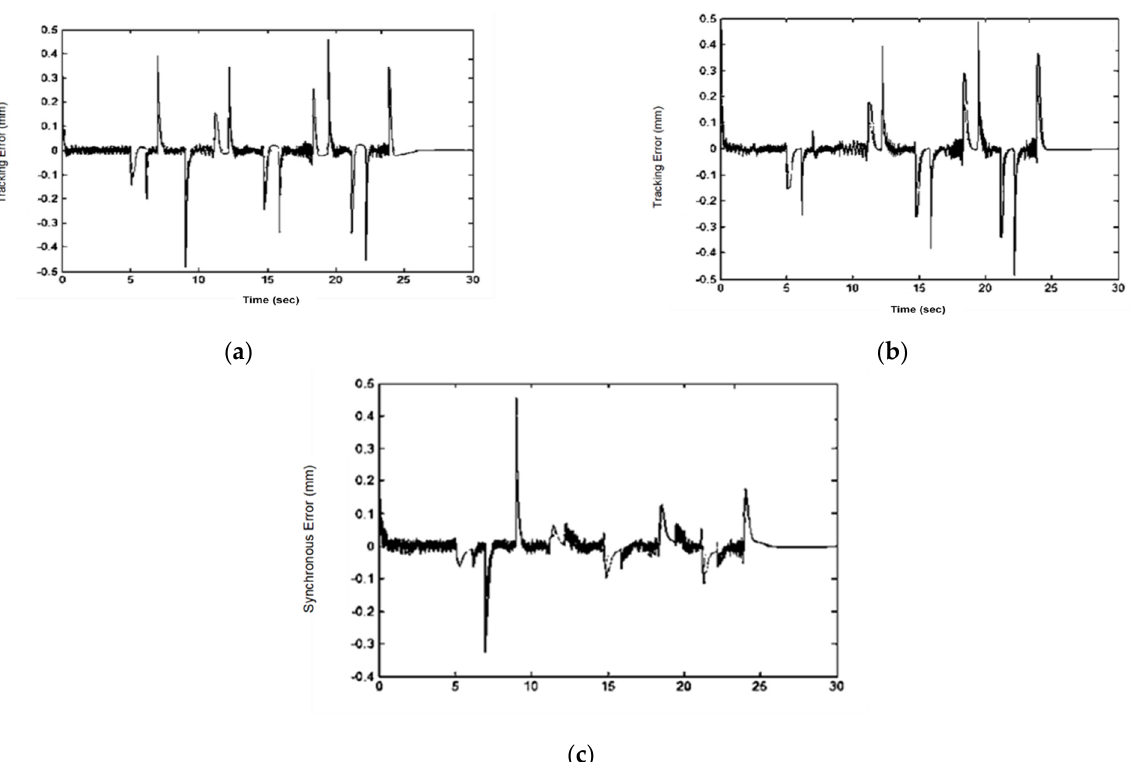
Figure 18. The performance of the PID compensator: ( a ) the tracking error of Axis 1; ( b ) the tracking error of Axis 2; ( c ) the synchronous error. Table 6. Synchronous performance under different control schemes. Performance Index